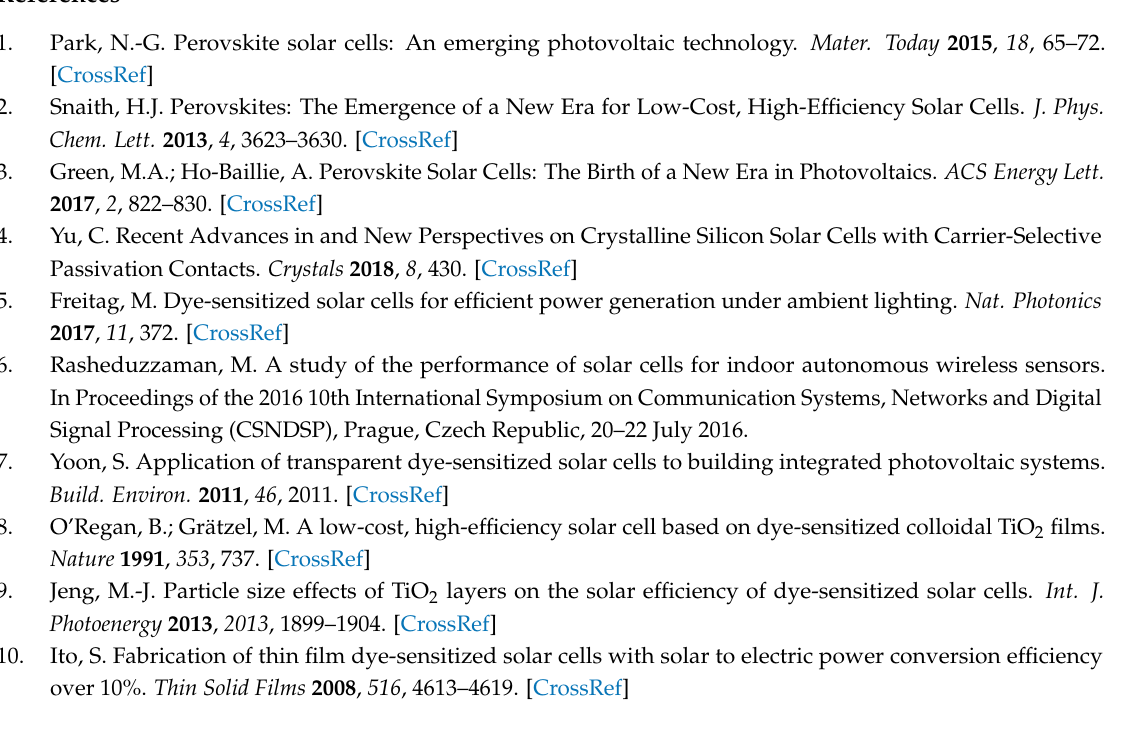
demonstrating the difference in scattering properties, Figure S2: The transmittances of undyed SANP-S and undyed SANP-T photoanode films with an average thickness of (10.0 ± 0.5 µ m). The inset is their corresponding visual images, Figure S3: Normalised IPCE,s of SANP-S and SANP-T devices sensitized with N719 and D149 highlighting scattering effects on IPCE responses and; Table S1: J-V parameters details of devices based on synthesized SANP-S and SANP-T sensitized either with D149 or